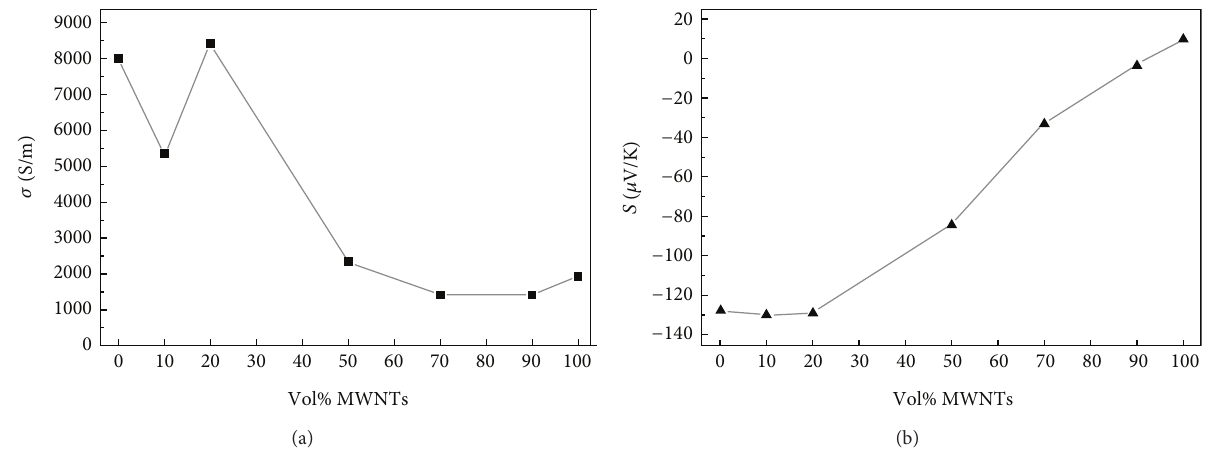
Figure 8: Effect of CNT doping on the electrical conductivity and Seebeck coefficient